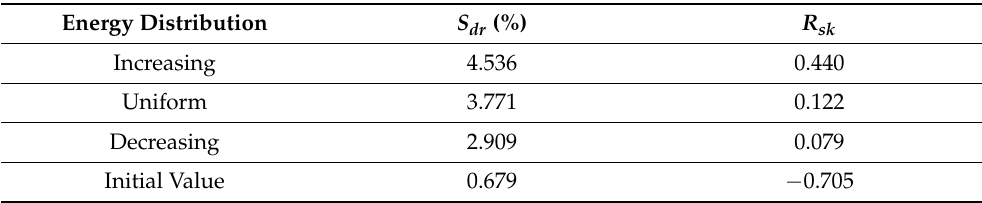
Table A12. S dr and R sk of